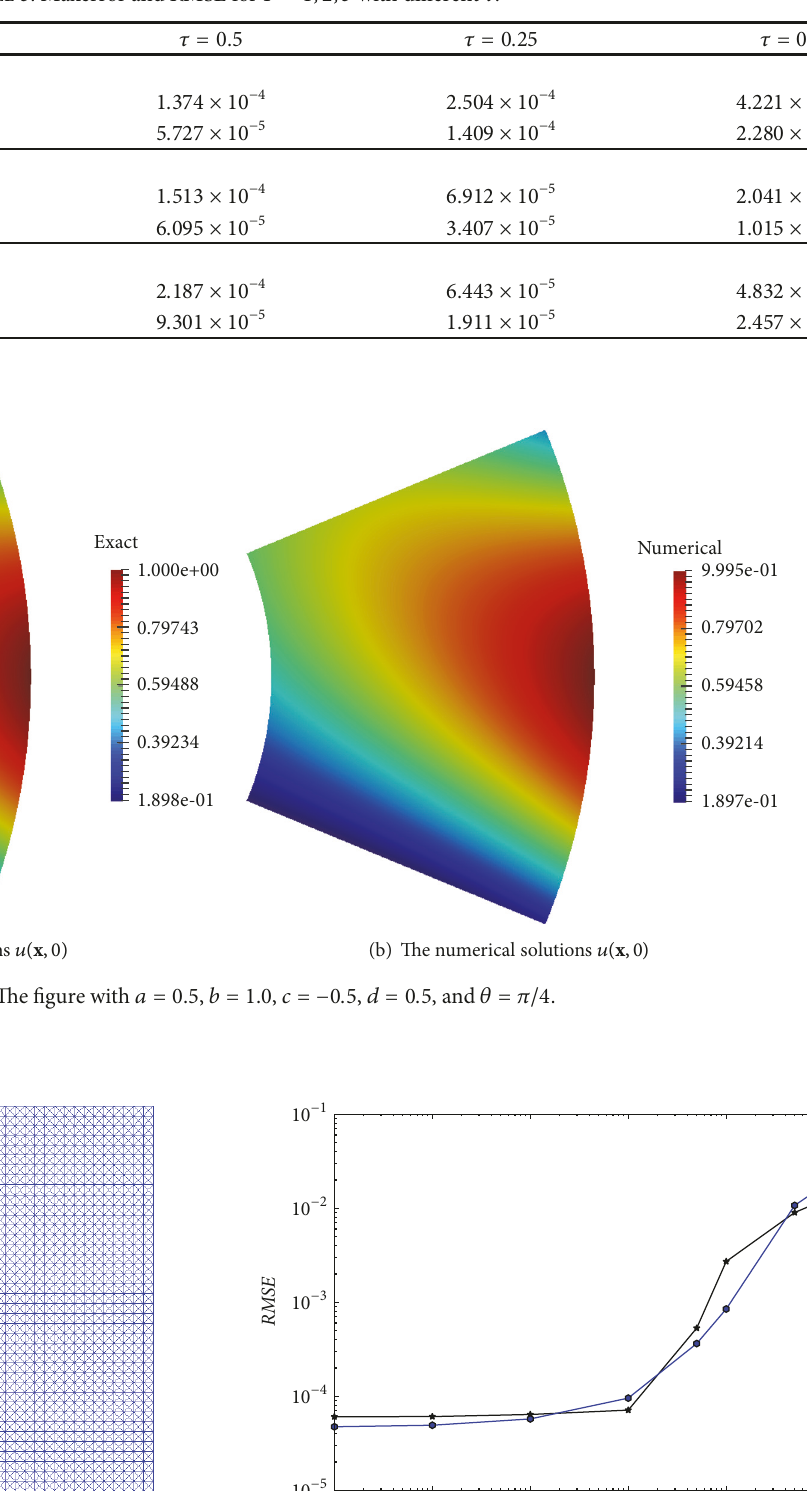
Table 3: Maxerror and RMSE for 𝑇 = 1, 2,3 with different 𝜏 .